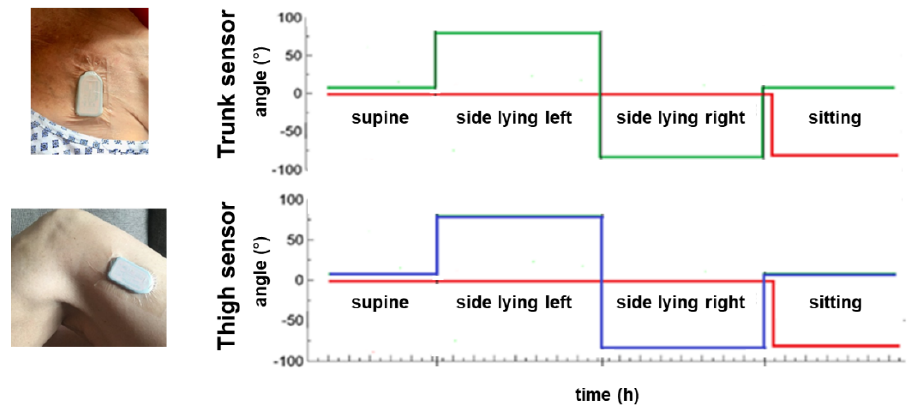
Figure 2. Schematic accelerometric recording of trunk and thigh sensors . The given angles define and distinguish the positions of supine, side-lying left/right or sitting in immobile patients during early neurorehabilitation ( green : transversal axis (x), red : longitudinal axis (y), blue : sagittal axis (z)). To distinguish these four positions in immobile patients, two axes are necessary per sensor due to the sensor’s perpendicular position in the frontal plane on the upper trunk and in the sagittal plane on the lateral thigh. Thus, the transversal and the sagittal axes are interchangeable between the trunk and the thigh sensor.